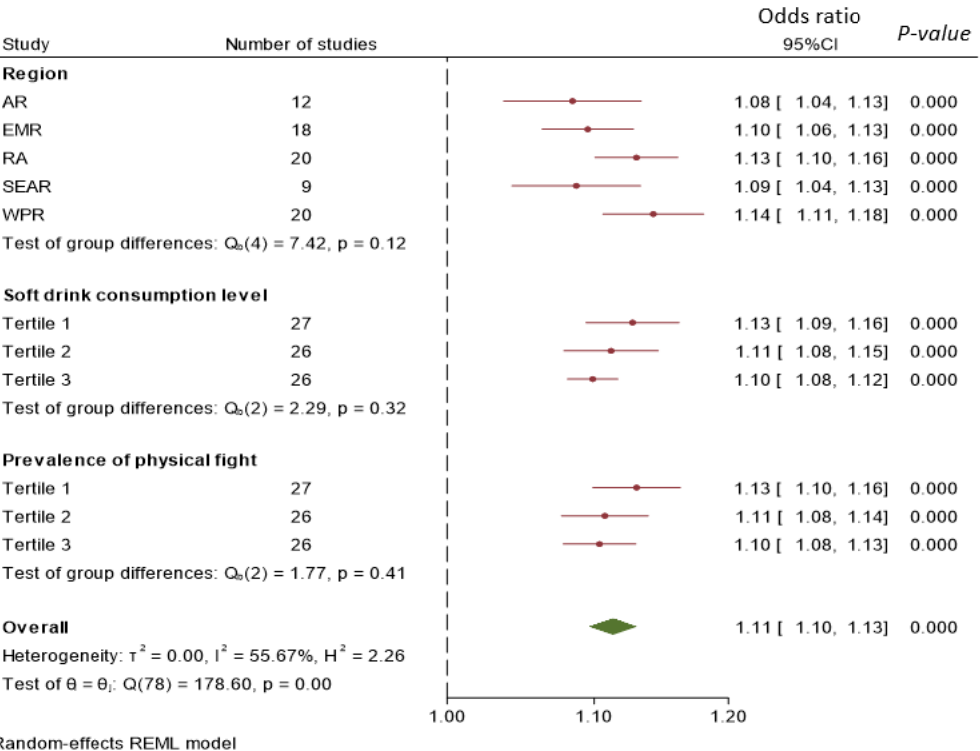
Figure 1. Forest plot of subgroup meta-analysis of the association between soft drink consumption and aggressive behavior. Abbreviation for regions: AR (African region), EMR (Eastern Mediterranean), RA (Region of Americas), SEAR (South East Asia Region), and WPR (Western Pacific Region). Values are odds ratio (OR) and 95% confidence interval (CI).